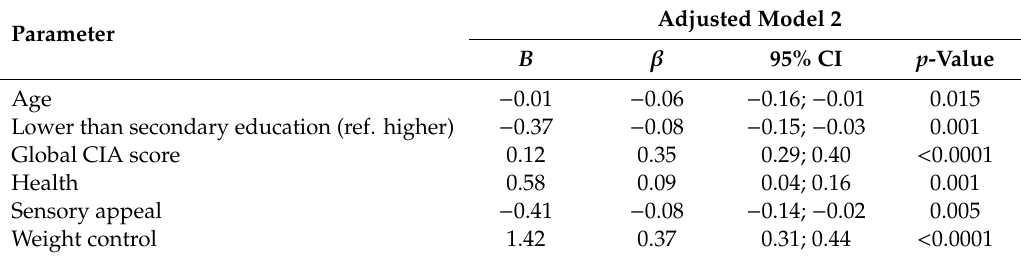
Table 6. Multiple linear regression analysis of orthorexic behaviors (ORTO-7) in the study sample.